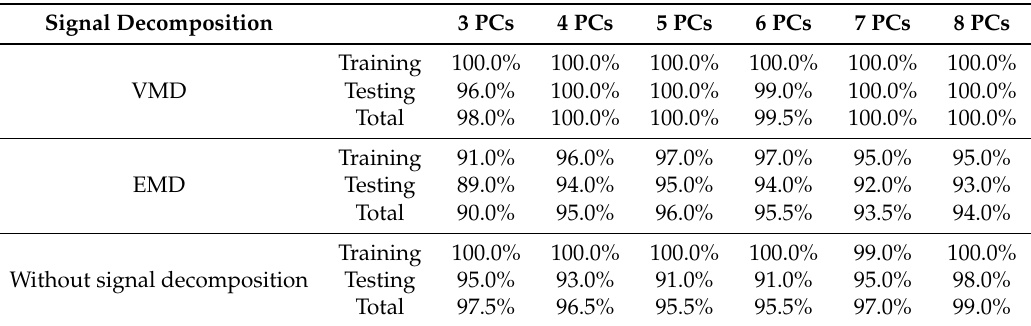
Table 6. Accuracy rate considering the effect of the signal decomposition methods. EMD, empirical mode decomposition. Signal